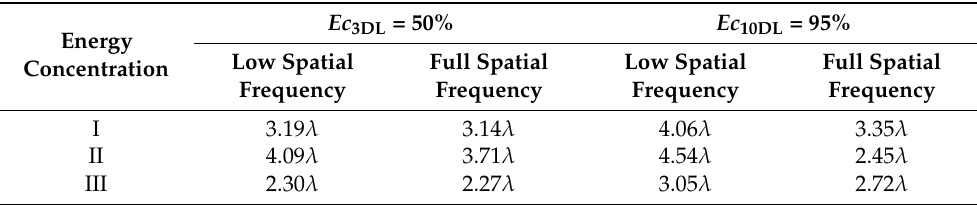
Table 2. Allowable PV values of original wavefront under Ec 3DL = 50% and Ec 10DL = 95%.